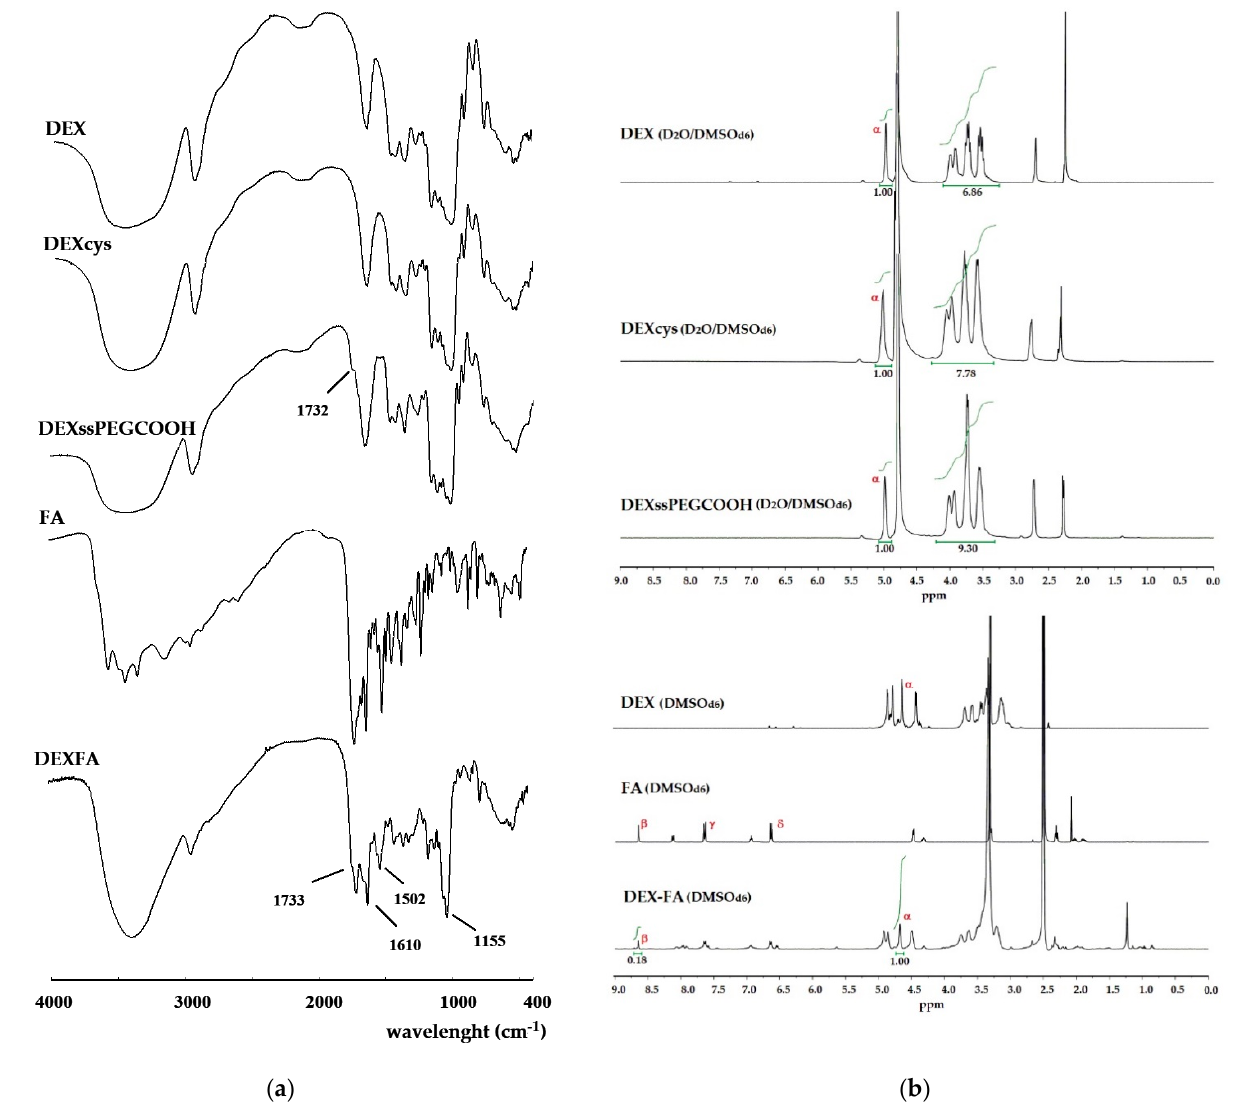
Figure 2. ( a ) FT-IR and ( b ) 1 H-NMR spectra of DEX and DEX conjugates.